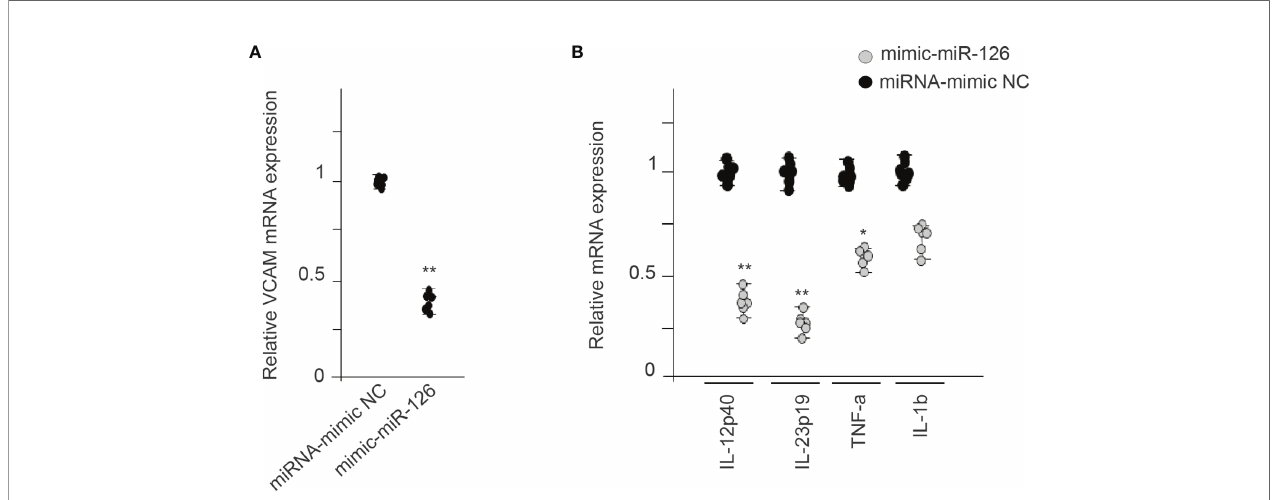
FIGURE 6 | MiR-126 in RMCs reduces proin fl ammatory genes. (A) Relative expression of VCAM1 mRNA levels in RMCs transfected with miRNA-mimic NC or mimic-miR-126. Values are expressed as mean ± SEM. Statistical analysis was performed by ANOVA followed by Tukey ’ s post-hoc test. ** p < 0.01 vs. miRNA- mimic NC ( N = 6). (B) qRT-PCR analysis of proin fl ammatory genes in RMCs transfected with miRNA-mimic NC or mimic-miR-126. Values are expressed as mean ± SEM. Statistical analysis was performed by ANOVA followed by Tukey ’ s post-hoc test. * p < 0.05 and ** p < 0.01 vs. miRNA-mimic NC ( N =